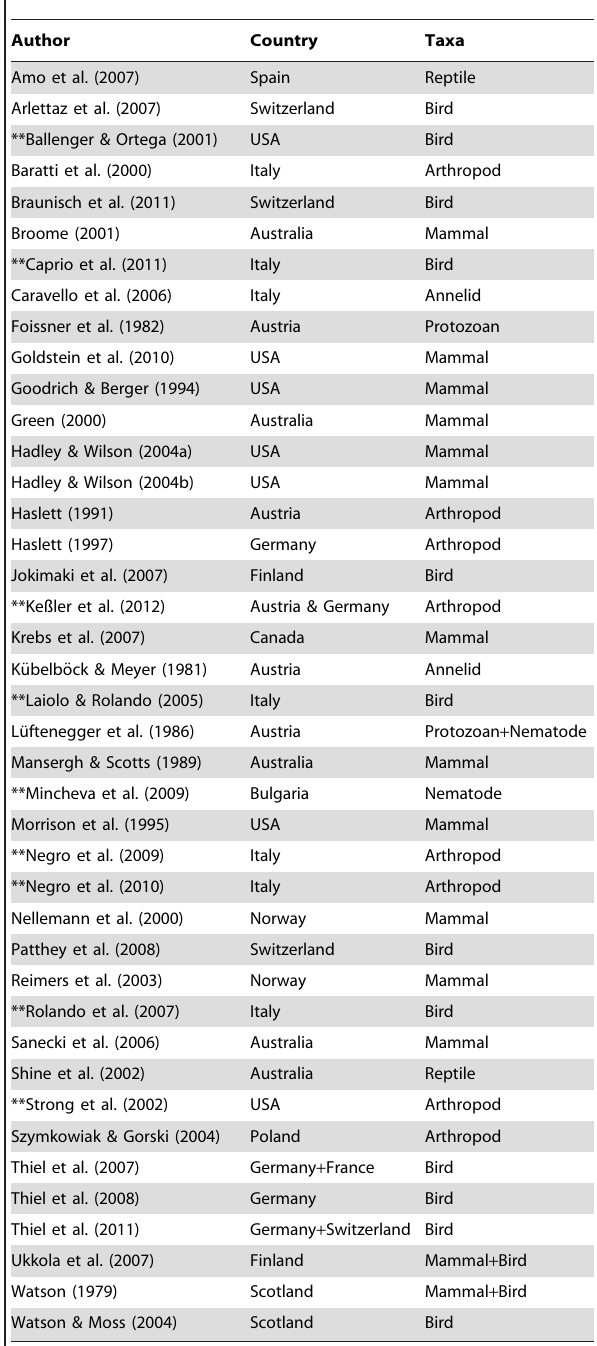
Table 1. Details of the 41 studies* investigating the impacts of winter recreation on alpine and subalpine fauna.